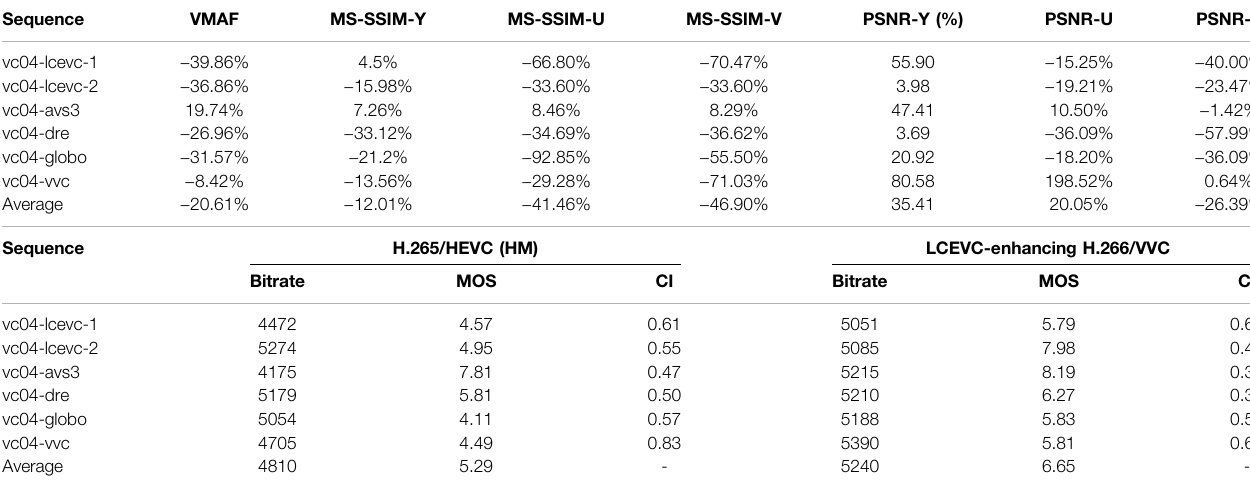
TABLE 6 | BD-rate savings for HLG sequence – Con fi guration